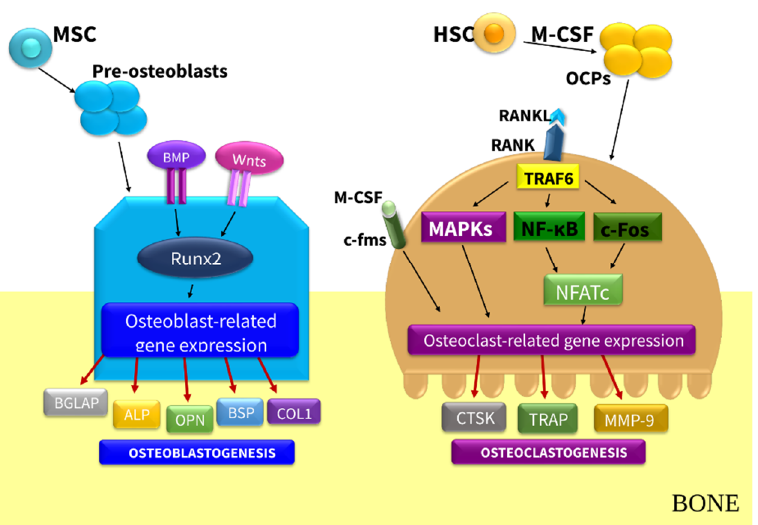
Figure 1. Bone remodeling. Abbreviations: ALP, alkaline phosphatase; BGLAP, bone-Gla-protein; BMP, bone morphogenic protein; BSP, bone sialoprotein; c-fms, colony-stimulating factor-1 receptor; COL1, collagen type 1; CTSK, cathepsin K; HSC, hemapoietic stem cells; MAPKs, mitogen-activated protein kinases; M-CSF, macrophage colony-stimulating factor; MMP-9, matric metalloproteinase 9; Msc, mesenchymal stem cell; NFATc, nuclear factor of activated T-cells; NFkB, nuclear factor-kappa B; OPN, osteopontin; OCPs, osteoclast precursors; RANK, receptor activator of nuclear factor kappa B; RANKL, receptor activator of nuclear factor kappa B ligand; Runx2, runt-related transcription factor 2; TRAF6, Tumor necrosis factor receptor associated factor 6; TRAP, tartare-resistant acid phosphatase.